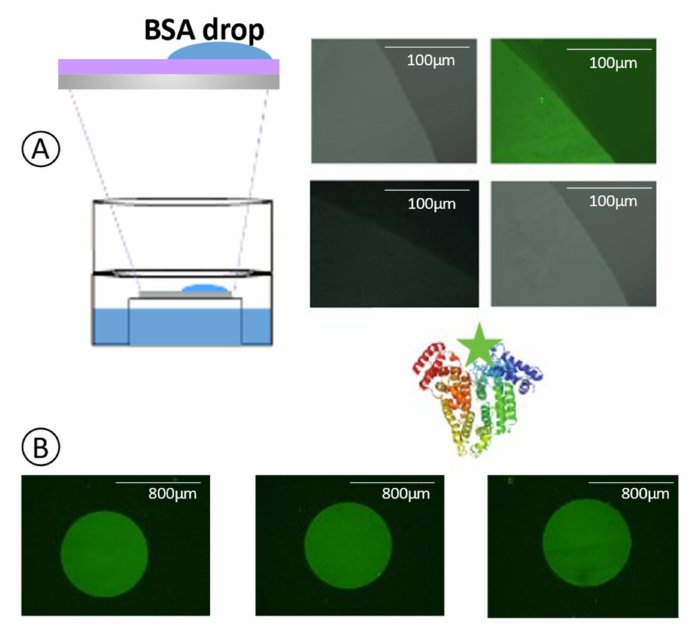
Figure 4. ( A ) Fluorescent microscope image from SiO 2 biofunctionalization with BSA ( B ) and the labeled antibody on cells A, B, and C of one